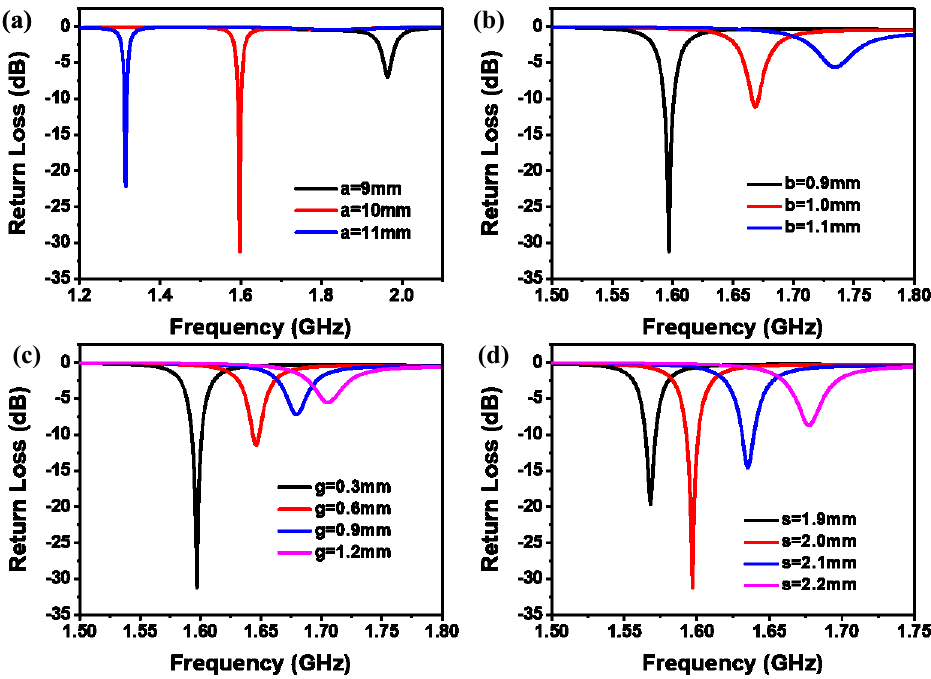
Figure 3. HFSS simulation optimization results. ( a ) CSRR outer diameter length a. ( b ) CSRR width b. ( c ) Opening width g. ( d ) CSRR spacing s. Table 1. The detailed parameters of the designed